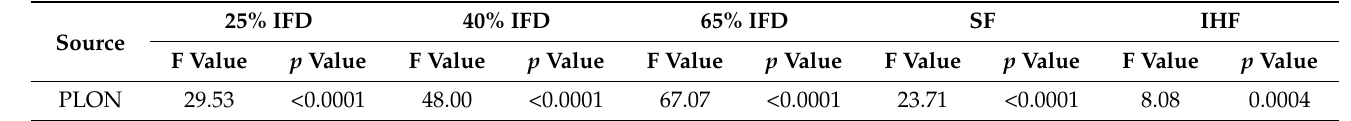
Table 3. ANOVA results performed on five factors.